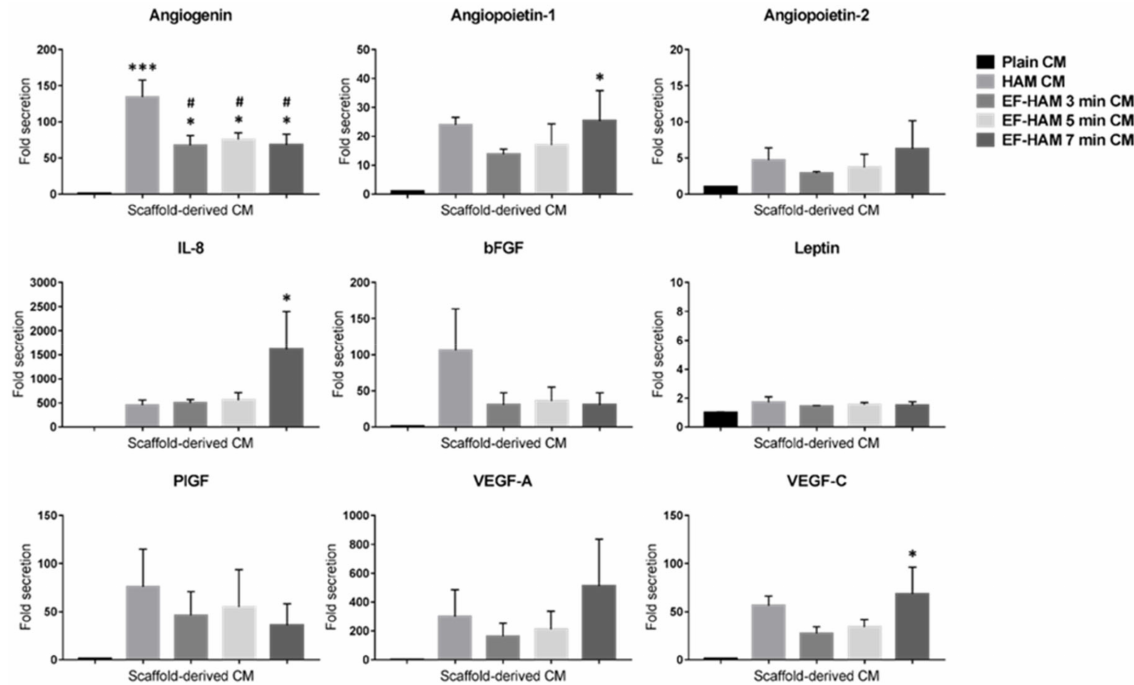
Figure 3. Detection of multiple proangiogenic factors secreted by SkM-seeded HAM and EF-HAM scaffolds. Conditioned medium (CM) from each experimental condition was collected in serum-free culture medium for 72 h before the proangiogenic factors were measured via multiplex analysis. The values are represented as mean ± SEM (* p < 0.05 or *** p < 0.001, compared with plain CM; # p < 0.05, compared with HAM CM; One-way